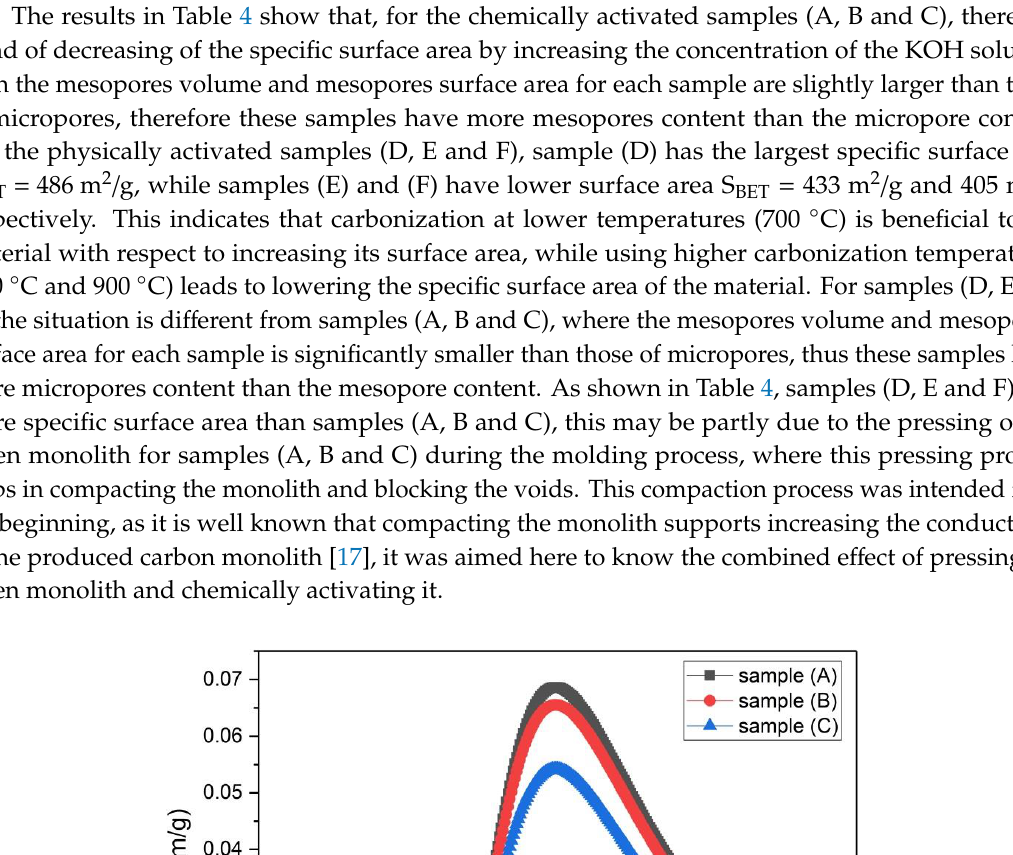
Table 4. Porous Structure Characteristics.